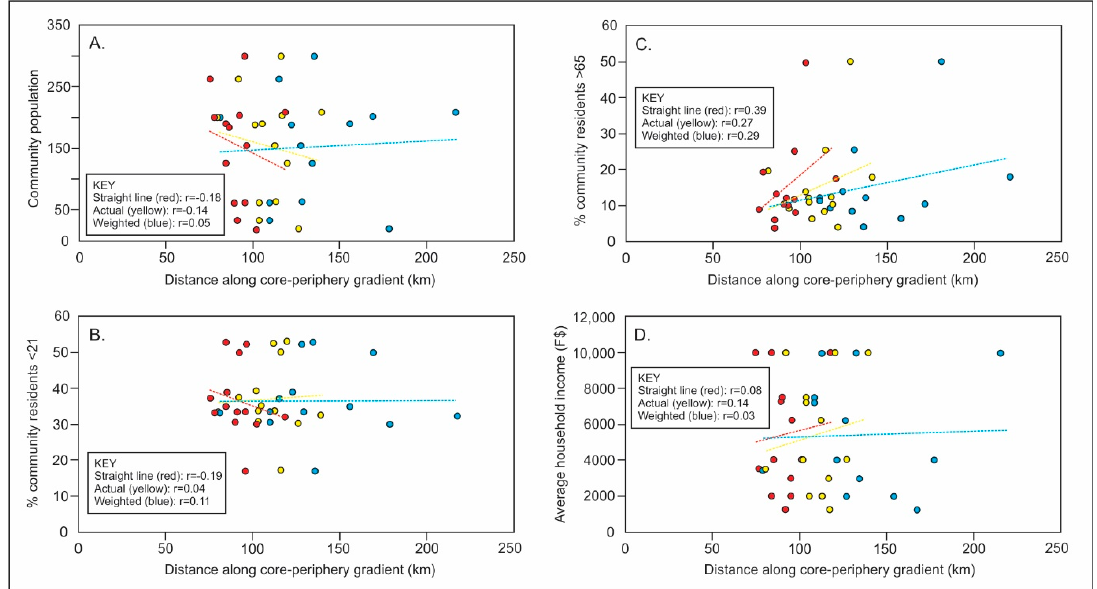
Figure A1. The three distance measures (see Figure 2 and Table 1) plotted against community population ( A ), community residents <21 years ( B ) and >65 years ( C ), and average household income ( D ).